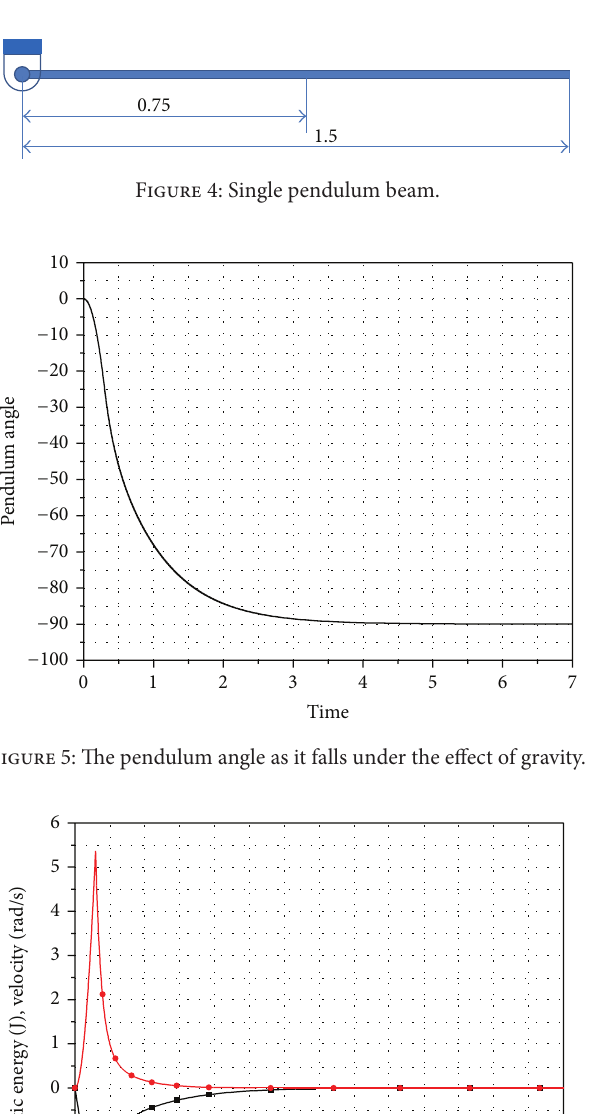
value of the kinetic energy. When the pendulum reaches this target value, it would have reached the static equilibrium.